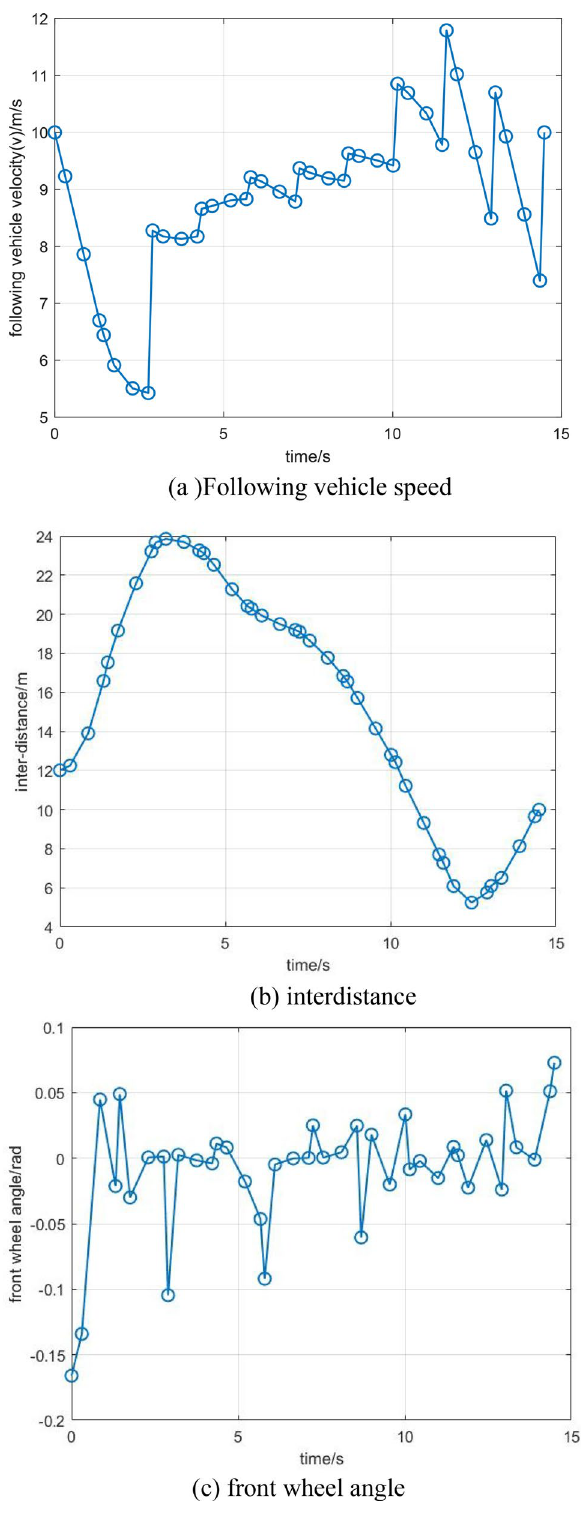
Figure 3. ( a ), ( b ), and ( c ) Driving states of the following